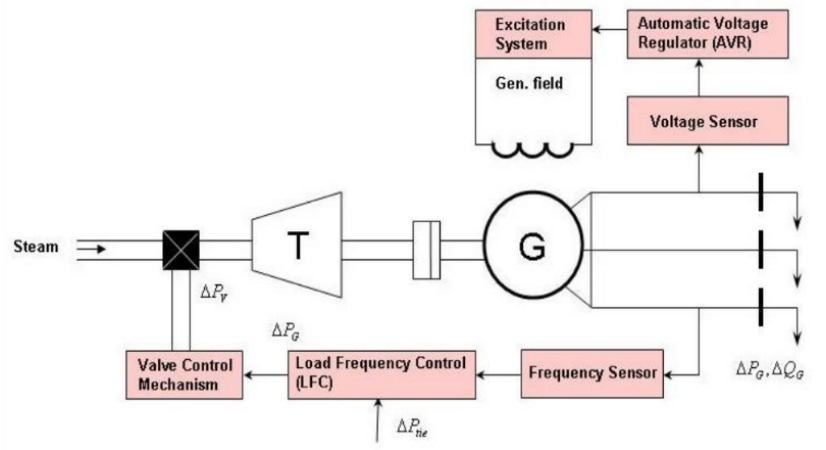
Figure 1. AGC components and connection to power